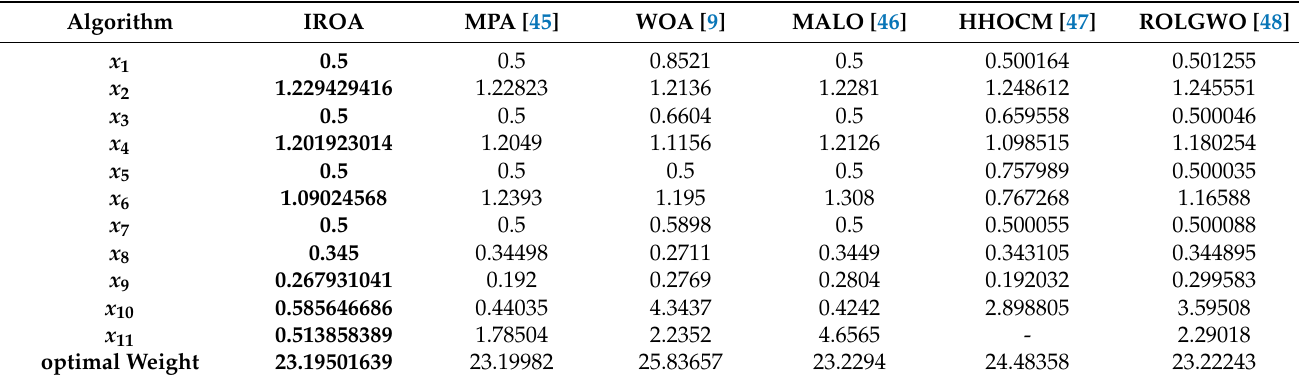
Table 13. Experimental results of car crashworthiness